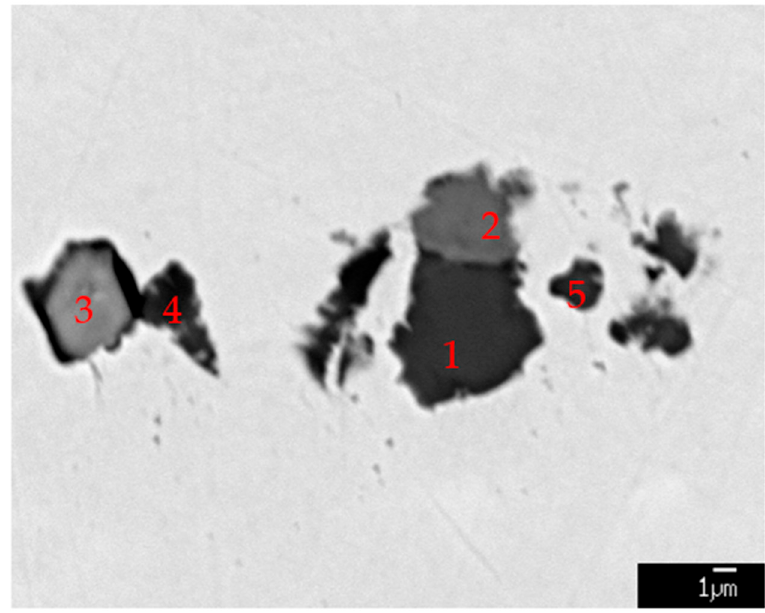
Figure 14. The element distribution of typical multiphase inclusion. A large-sized multiphase inclusion is shown in Figure 15 and the results of EPMA analysis for each phase are listed in Table 5. The main body of this large-sized inclusion consisted of CaO-Al 2 O 3 -SiO 2 (red number 1) and CaO-TiO x (red number 2). It seemed that this large-sized inclusion was crushed and separated into several parts composed of (Ca, Mn)S (red number 3), CaO-Al 2 O 3 -MgO (red number 4) and CaO-SiO 2 (red number 5) during the rolling process of TMCP, so it spread along the rolling direction.